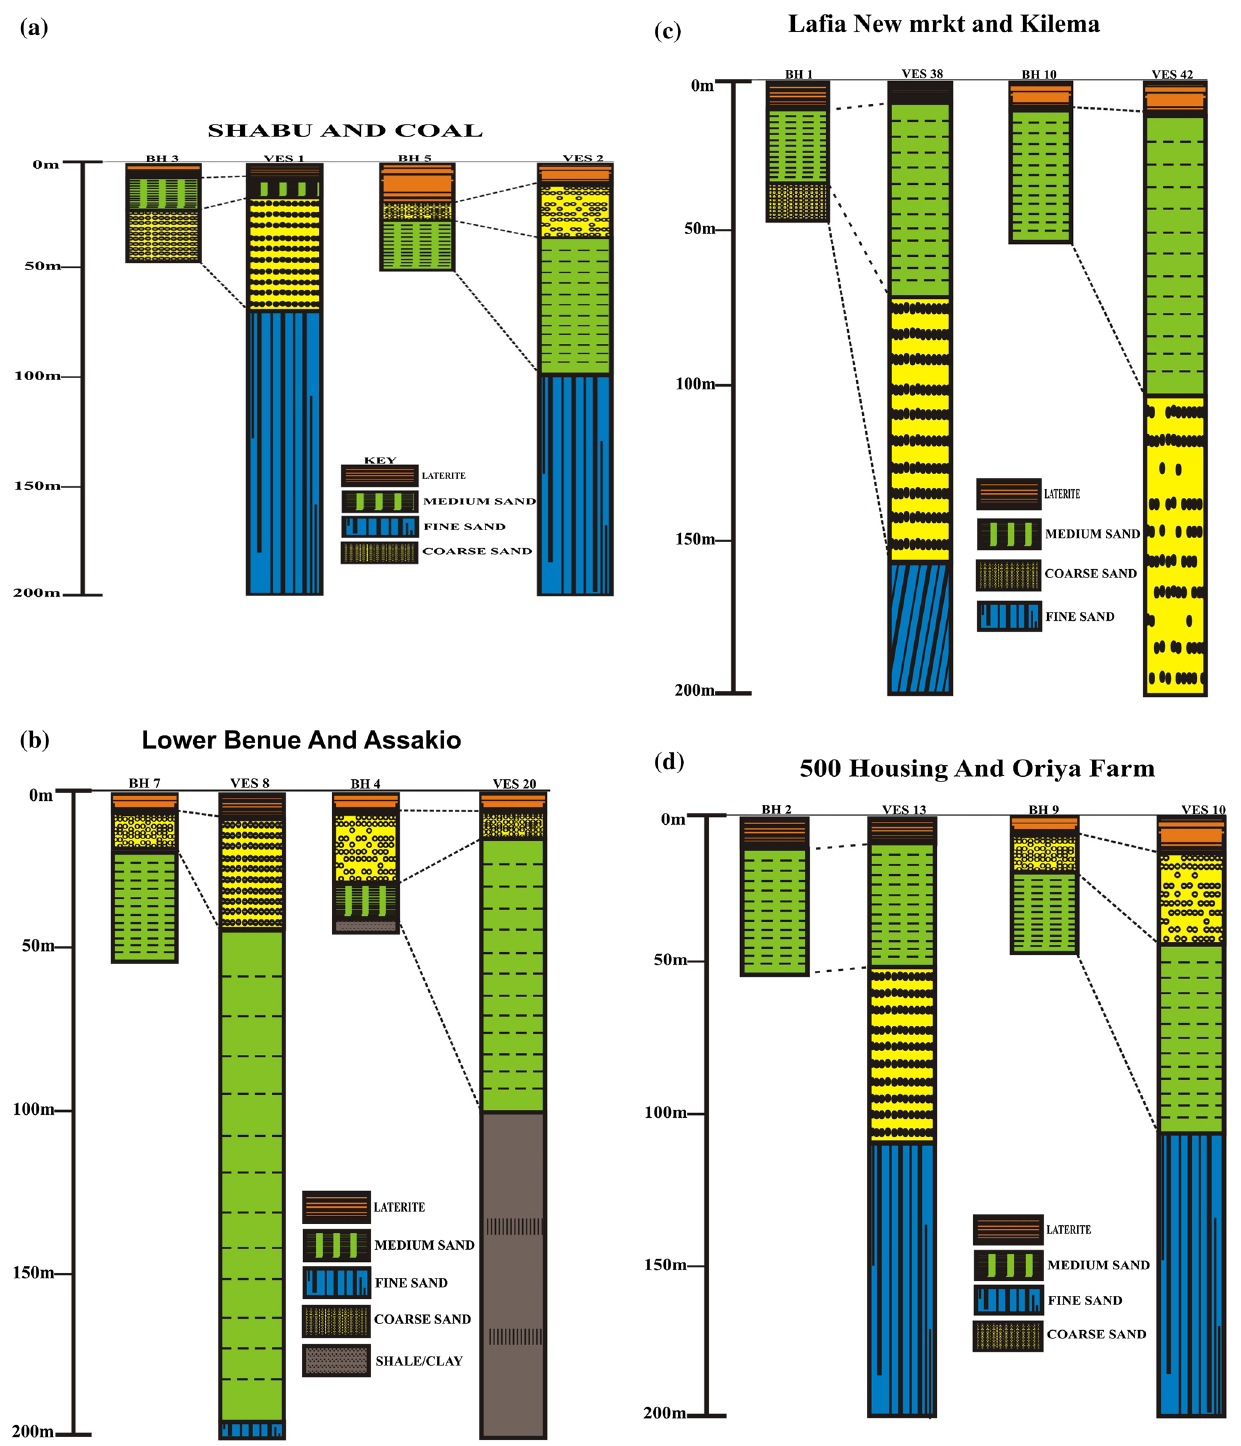
Fig. 5 a Lithologic correlation of borehole log and VES-inferred lay- ers (VES 1 and VES 2). b Lithologic correlation of borehole log and VES-inferred layers (VES 8 and 20). c Lithologic correlation of bore-